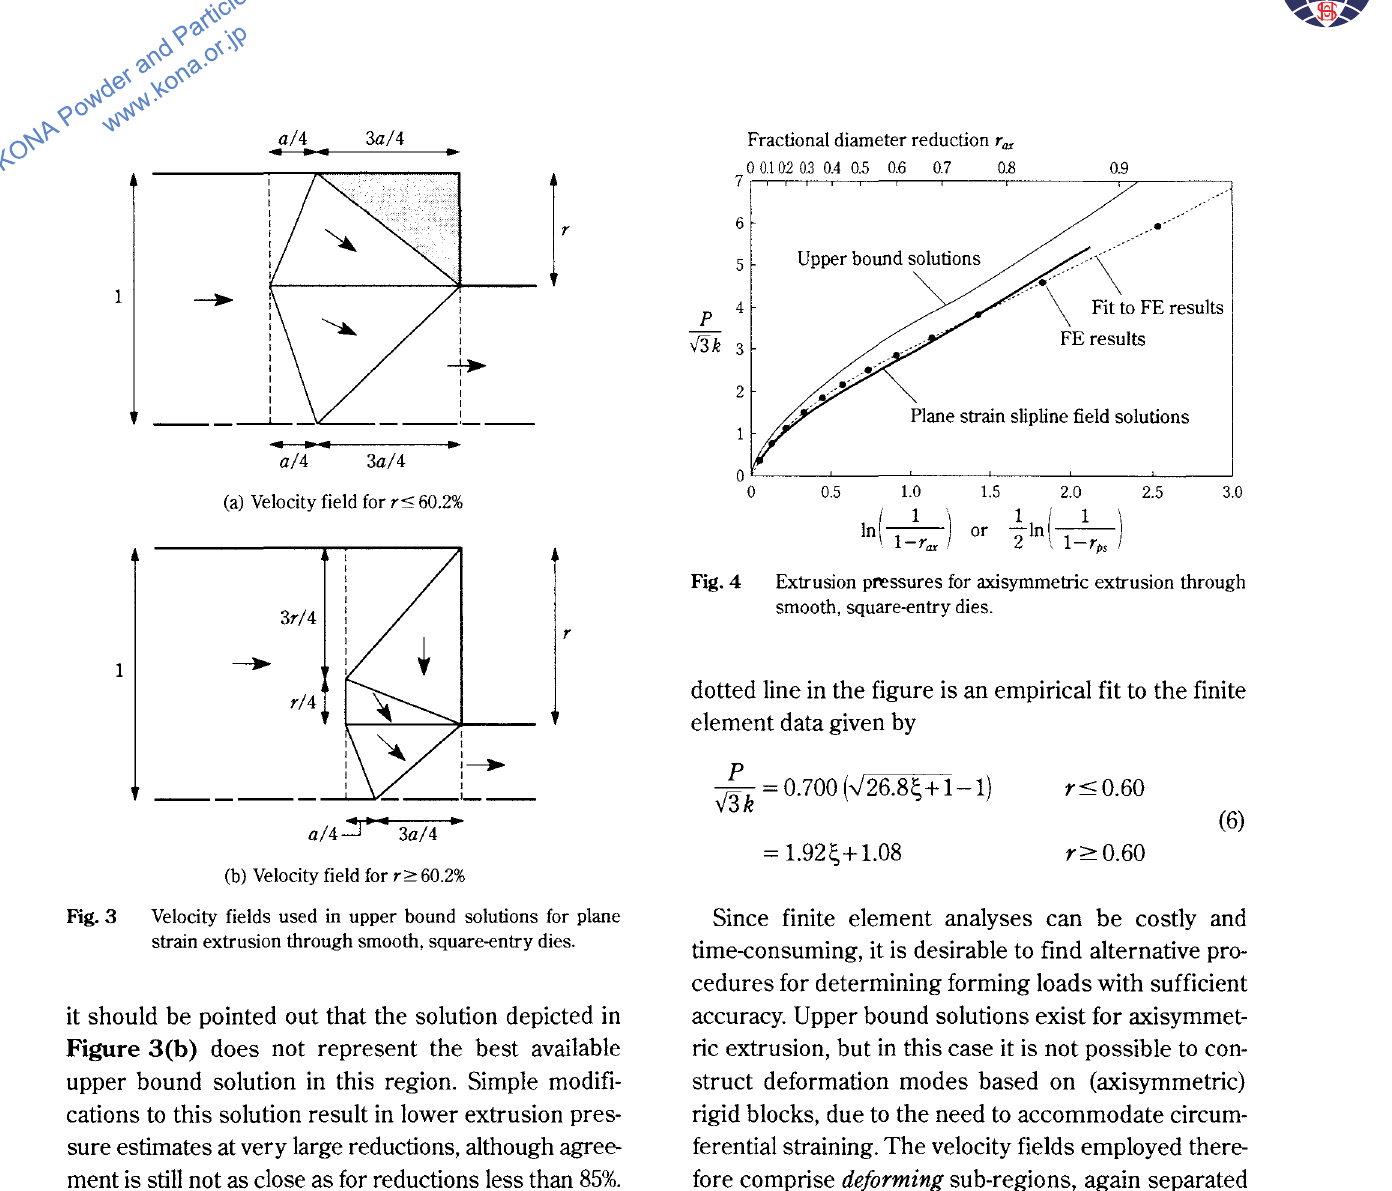
Fig. 4 Extrusion pressures for axisymmetric extrusion through smooth, square-entry